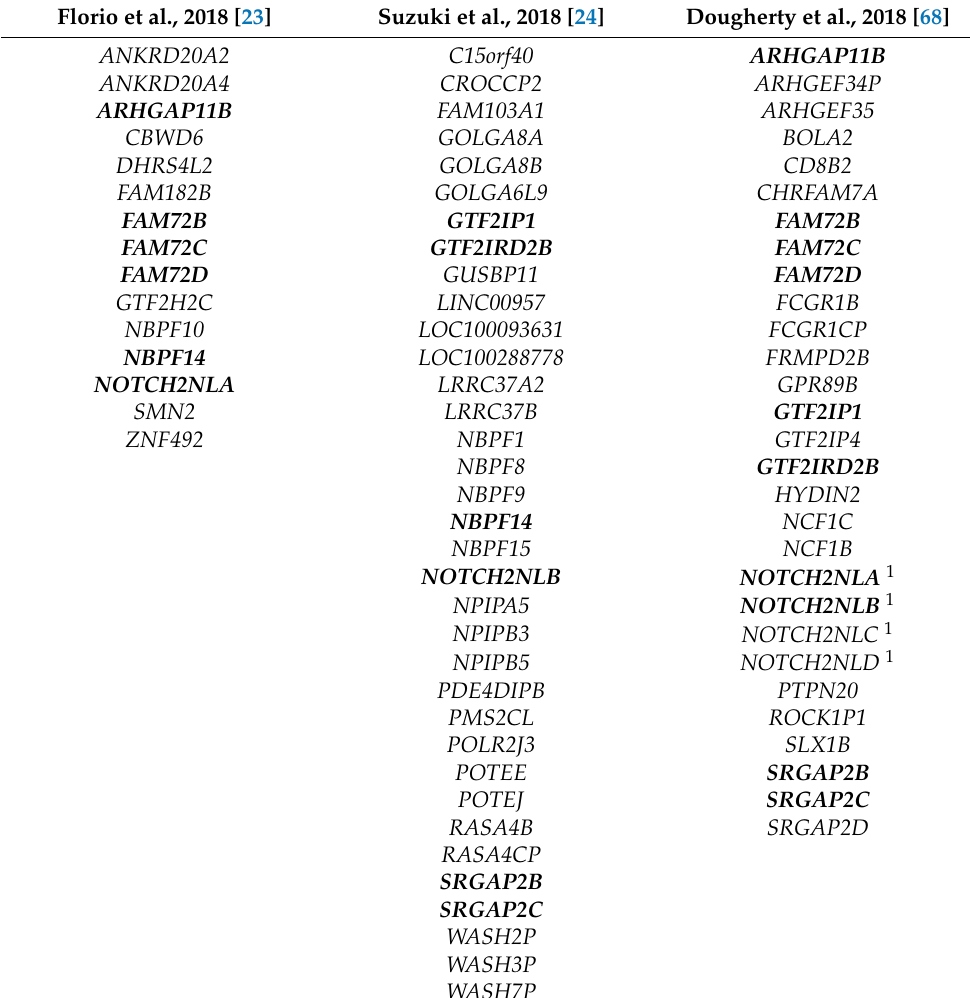
Table 3. Human-specific genes that are expressed in the developing and/or adult brain (in alphabeti- cal order). Bold font indicates the 11 genes that were identified in two